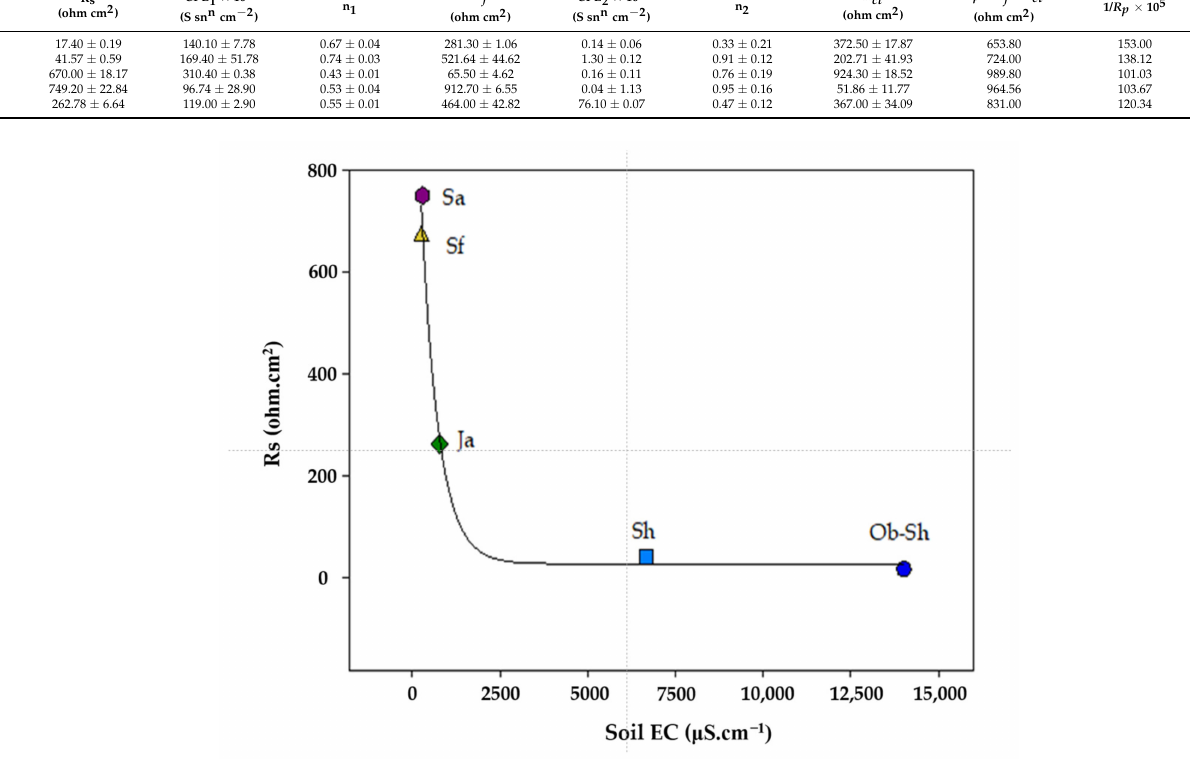
Figure 11. Variation in R s and soil EC for the studied soil